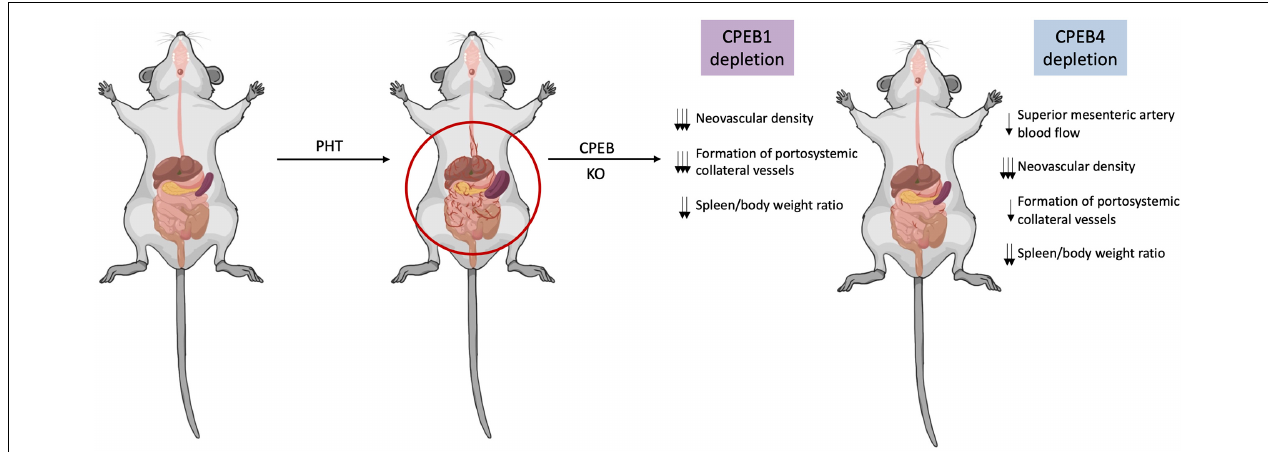
FIGURE 3 | CPEB silencing limits pathologic angiogenesis in portal hypertension and protects against disease progression. In a context of portal hypertension (PHT), pathological neovascularization increases significantly contributing to increase splanchnic blood flow and portosystemic collateral vessels. Upon CPEB1 or CPEB4 depletion in animal models of PHT, splanchnic neovascular density is markedly and significantly reduced, while preexisting vasculature density remains untouched. The formation of portosystemic collateral vessels is also diminished after CPEB1 or CPEB4 depletion in a context of PHT. CPEB1 or CPEB4 ablation also prevents the PHT-induced increase in the spleen/body weight ratio, suggesting attenuation of portal